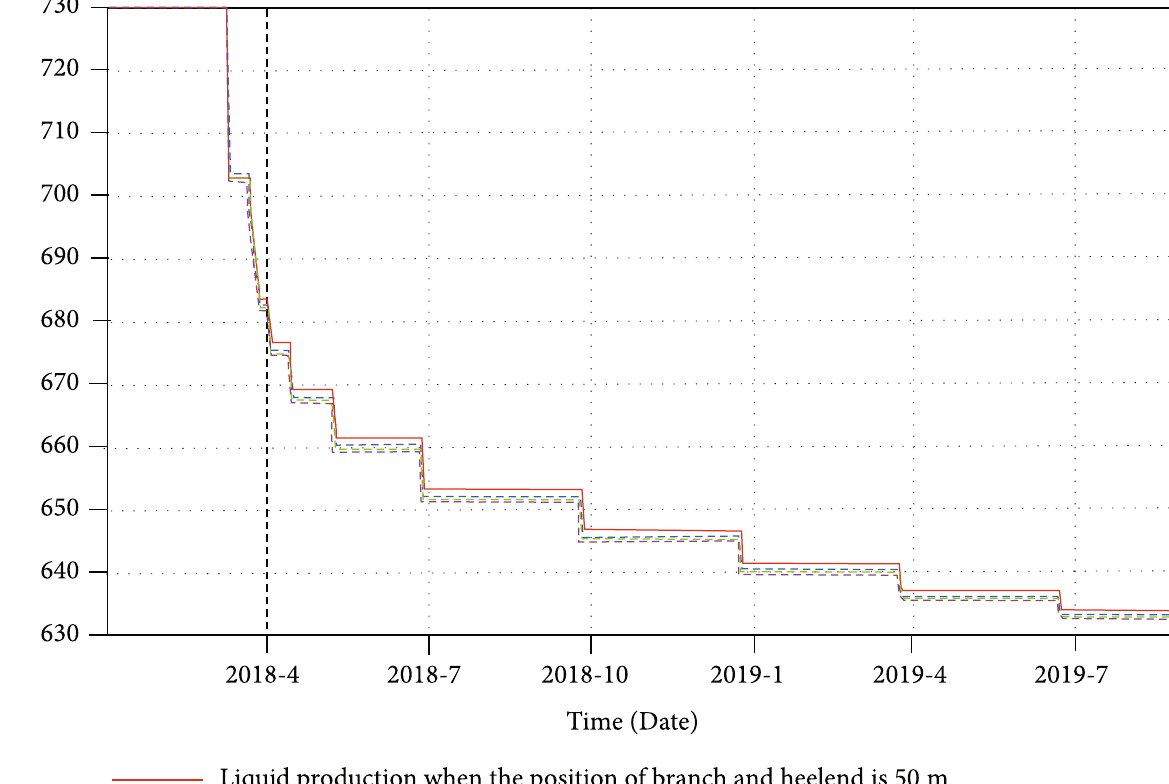
Figure 18: Production with di ff erent branch